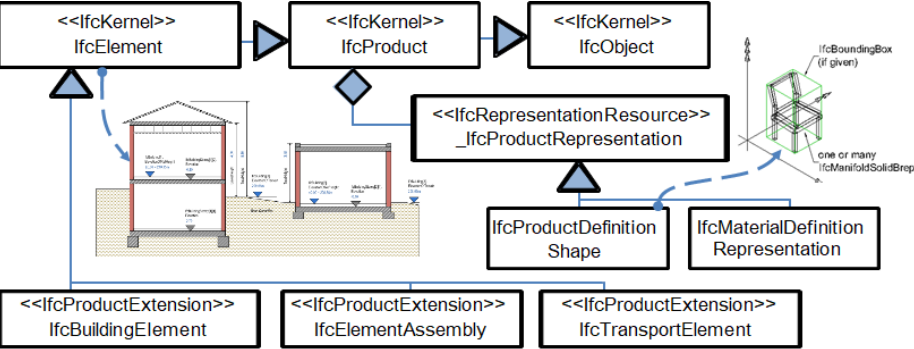
Figure 2. Major structure expression of IFC (BuildingSmart).